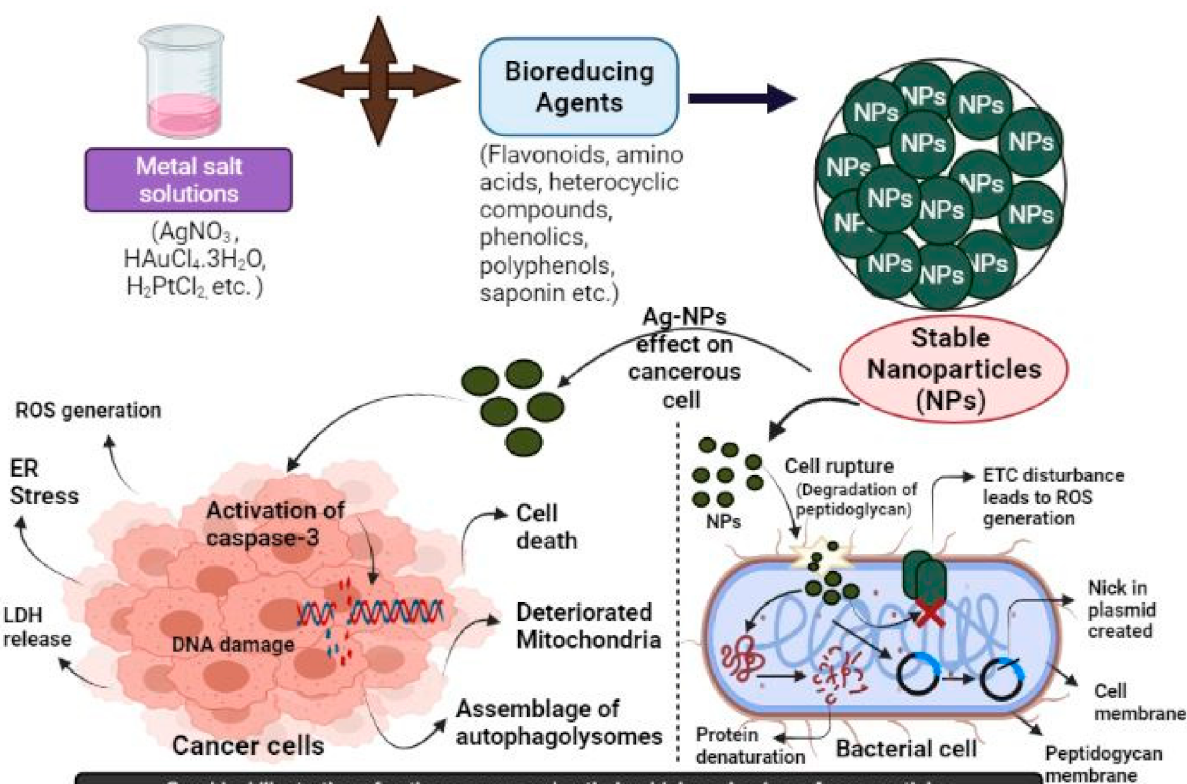
Figure 1. Metal salt solutions (AgNO 3 , HAuCl 4 · 3H2O, H 2 PtCl 2 ) after treatment with